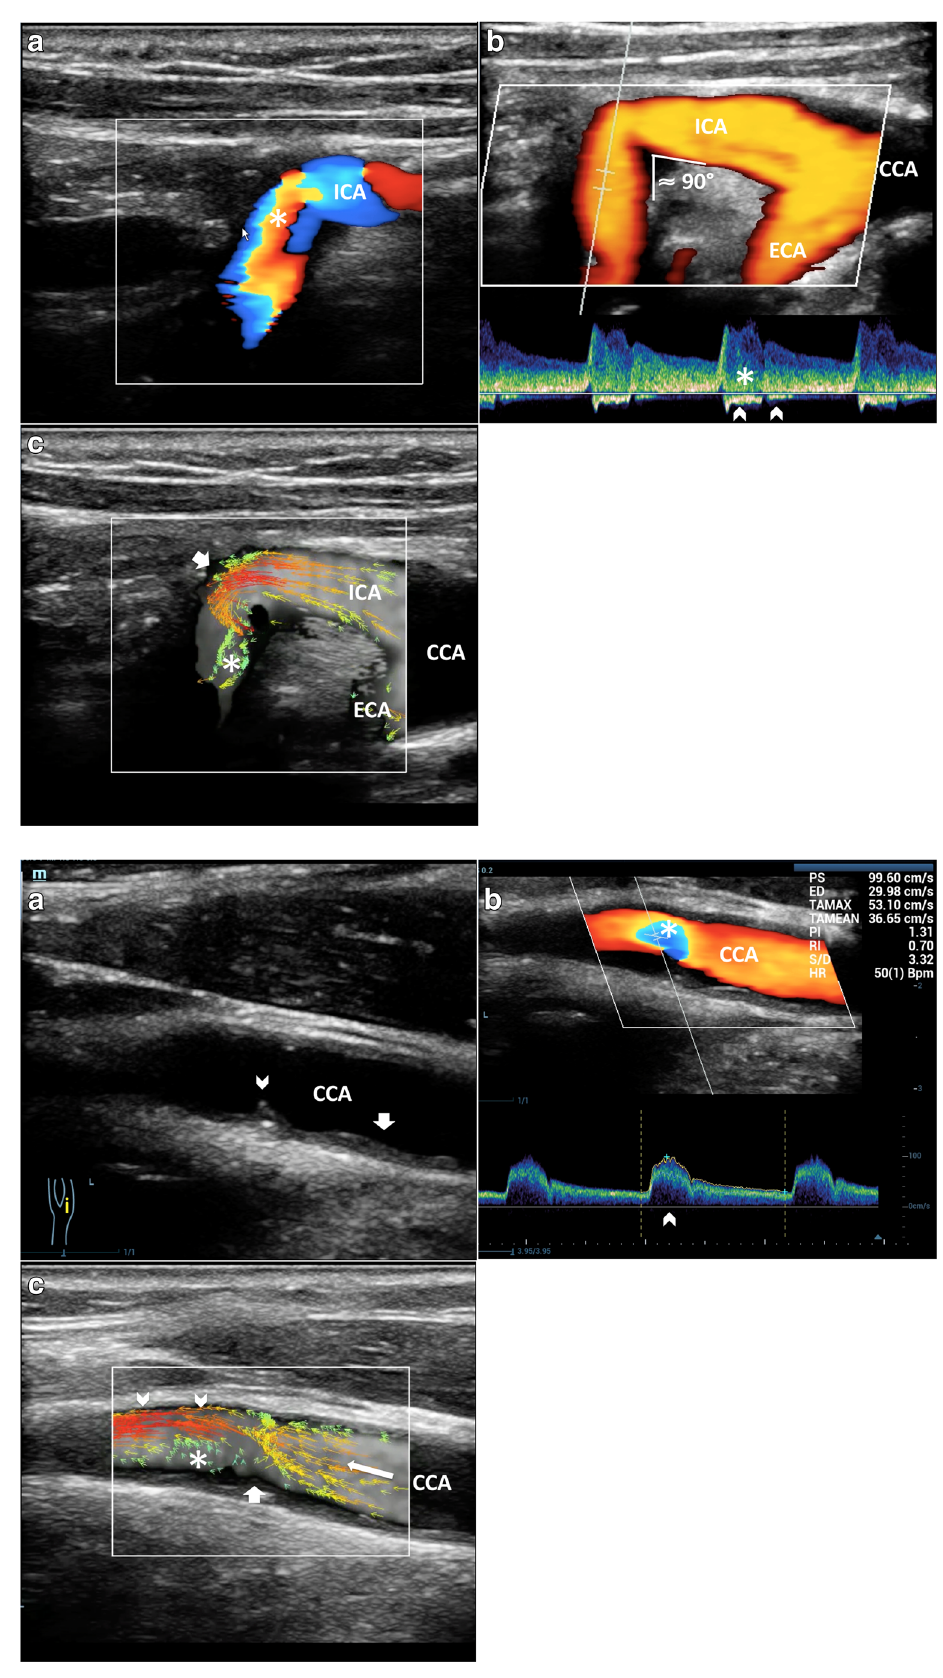
Fig. 7 Flow assessment in kinked ICA (angle ≈ 90°). a ) CD shows a mosaic of colors — aliasing artifact (*). b ) Power Doppler outlines the lumen reduction ( arrow ), without any quantification. PW bidirectional flow ( arrowhead ) and spectral broadening (*) highlight the turbulence. c ) VFI quantifies the stricture by showing high- velocity red vectors ( short arrow ) and strong vorticity (*). CCA = Common carotid artery. ICA = Internal carotid artery.